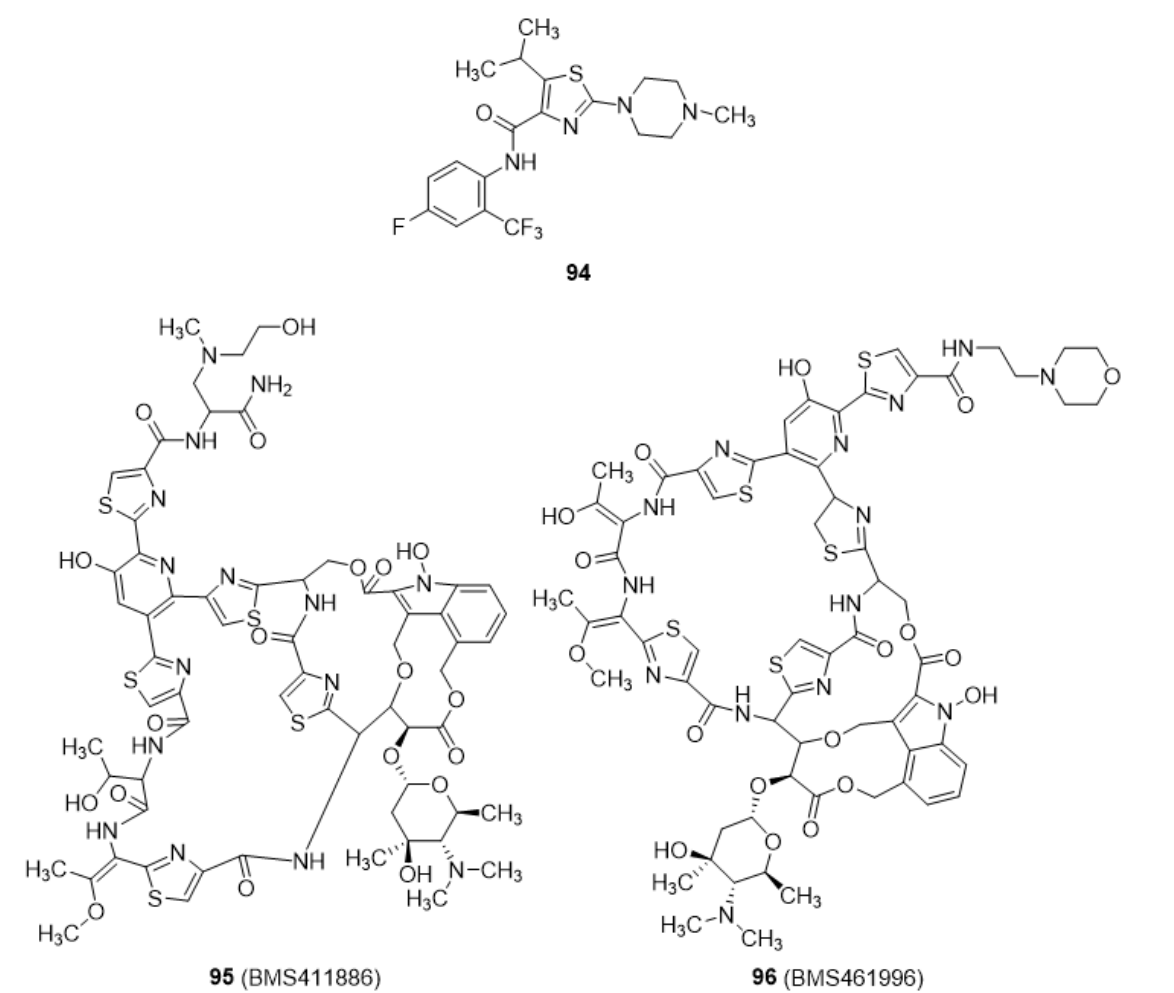
Figure 8. Thiazoles that have recently been developed and synthesized as possible antimalarial medicines.